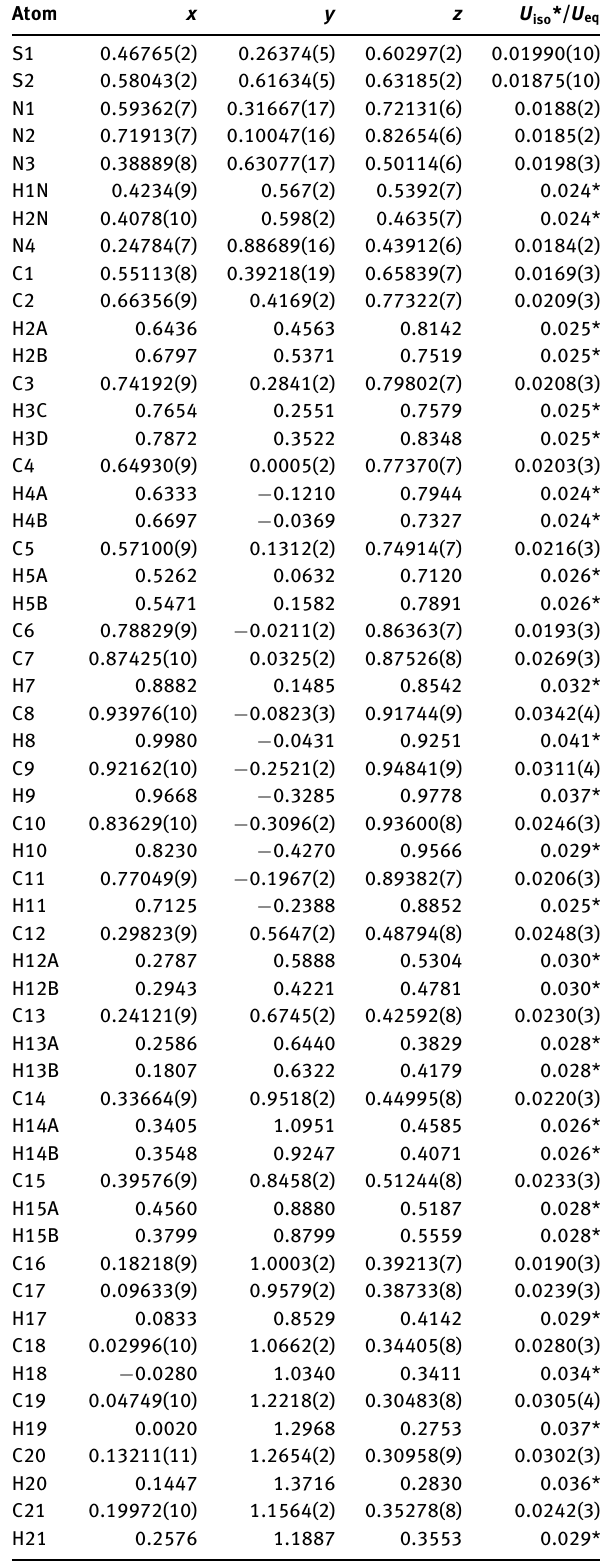
Table 2: Fractional atomic coordinates and isotropic or equivalent isotropic displacement parameters (Å 2